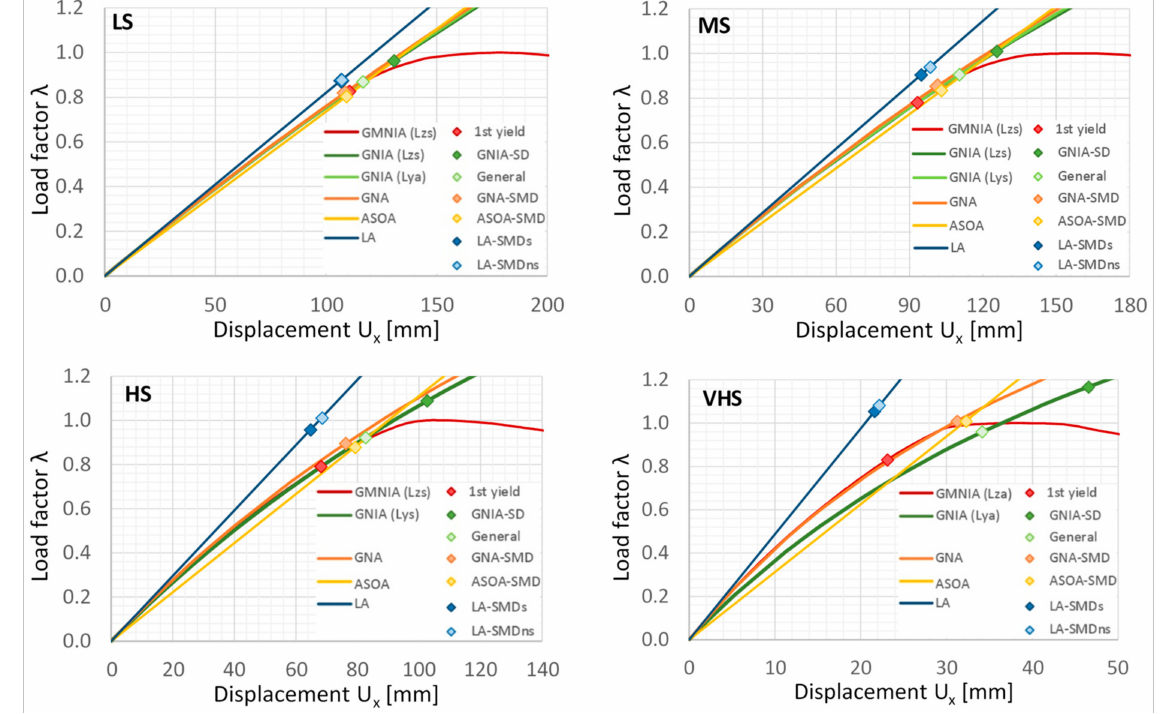
Figure 12. Comparison between the equilibrium paths of the examined frames marked with the point corresponds to